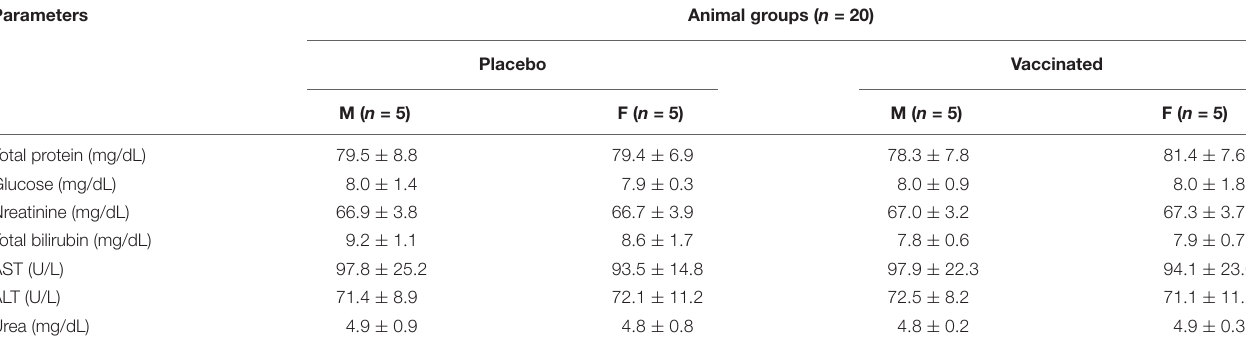
TABLE 2 | Average values (M ± SD) of the main biochemical parameters of hamster blood serum in determining the safety of the test drug.